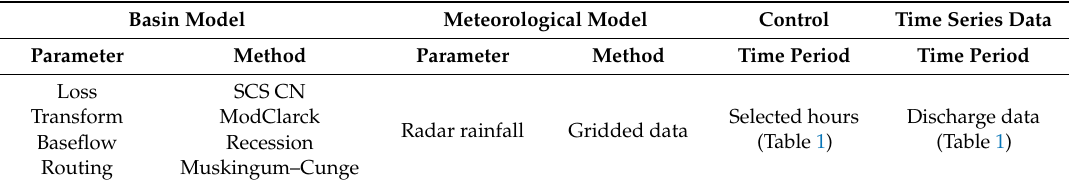
Table 2. Selected components for the